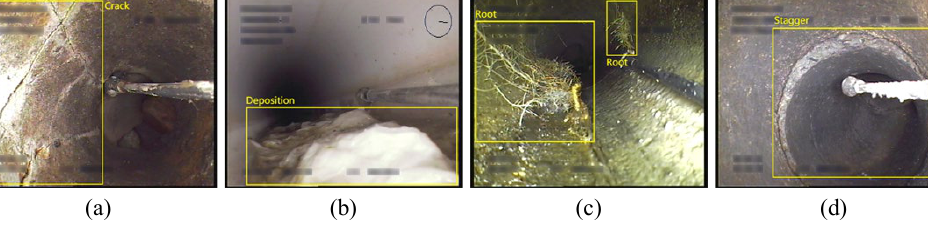
Figure 3. Sewer defect images labeled with bounding boxes: ( a ) crack; ( b ) deposition; ( c ) root; and ( d ) stagger.